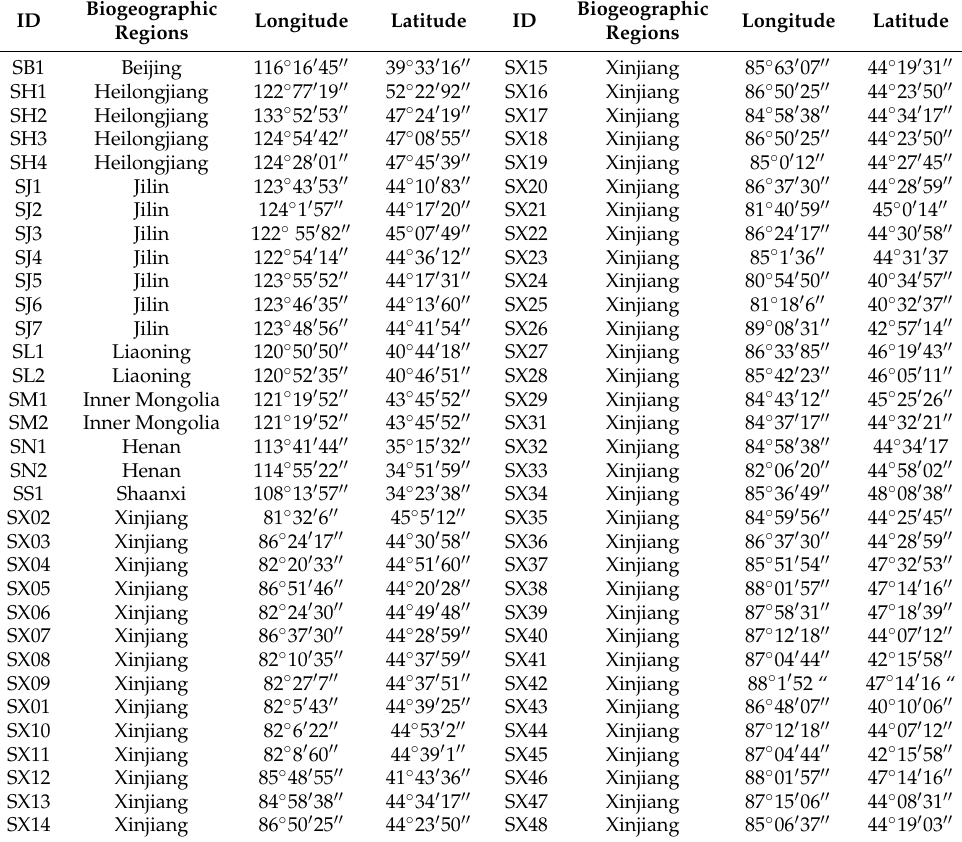
Table 1. Details of geographic and sampling information for S. nigrum populations in this